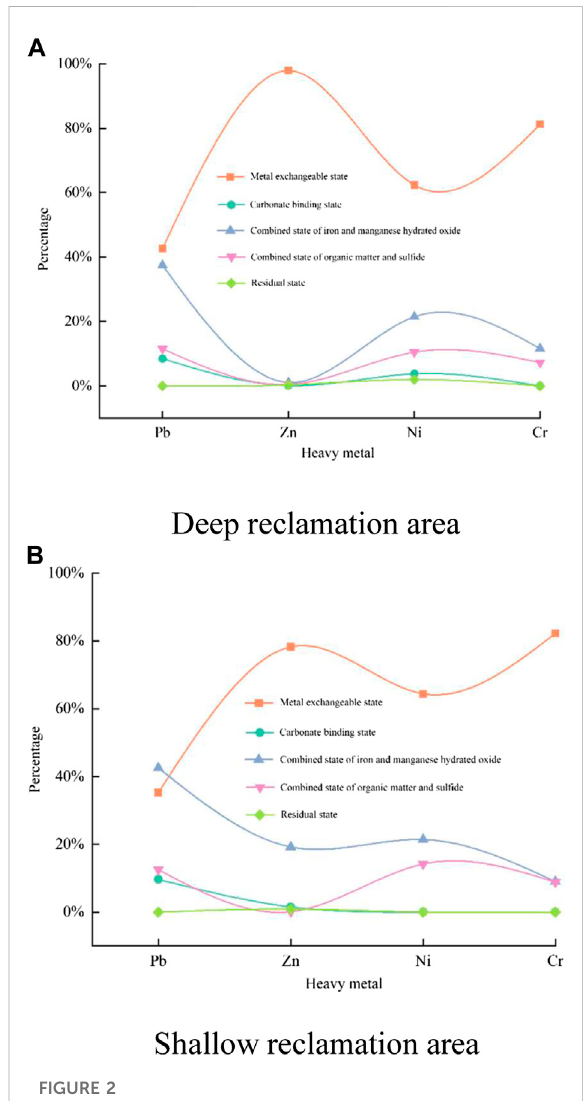
FIGURE 2 Distribution characteristics of soil heavy metal forms in